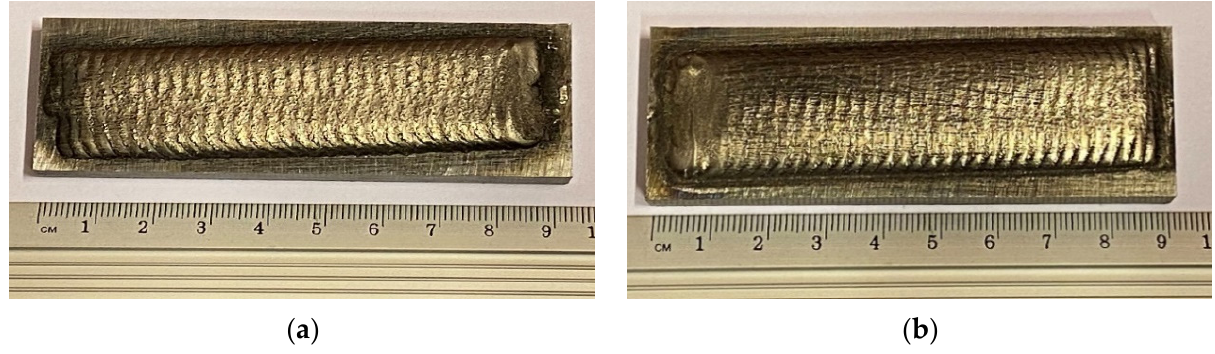
Figure 3. Images of prepared samples showing the as-deposited MMC surface coatings on the substrate material ( a ) specimen 2-PG prepared with PG MMC ( b ) specimen 2-PE prepared with PE MMC.